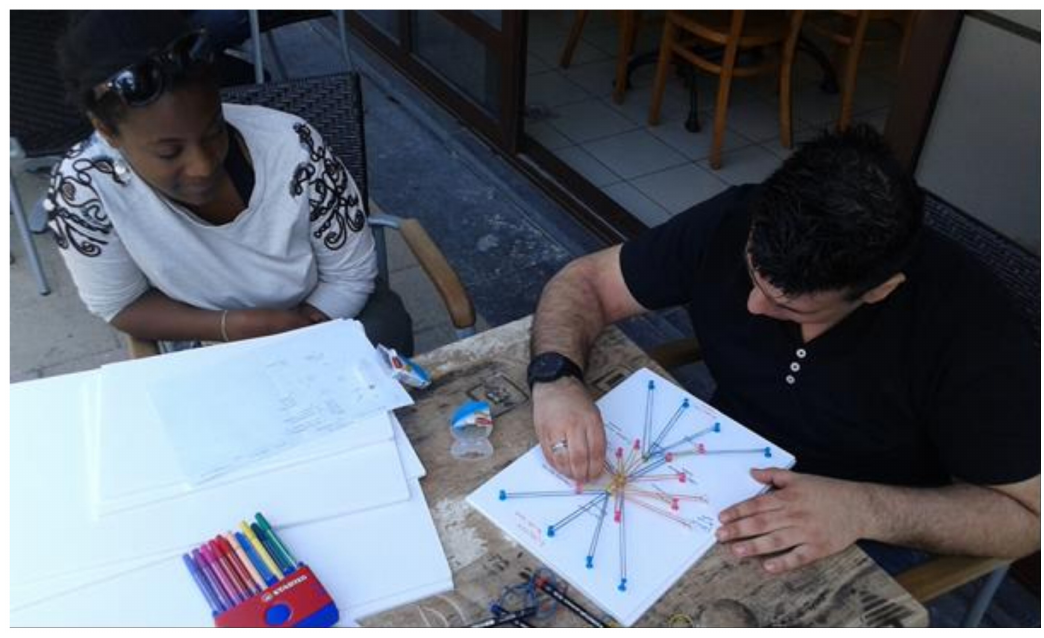
Figure 4. Mapping socio-economic